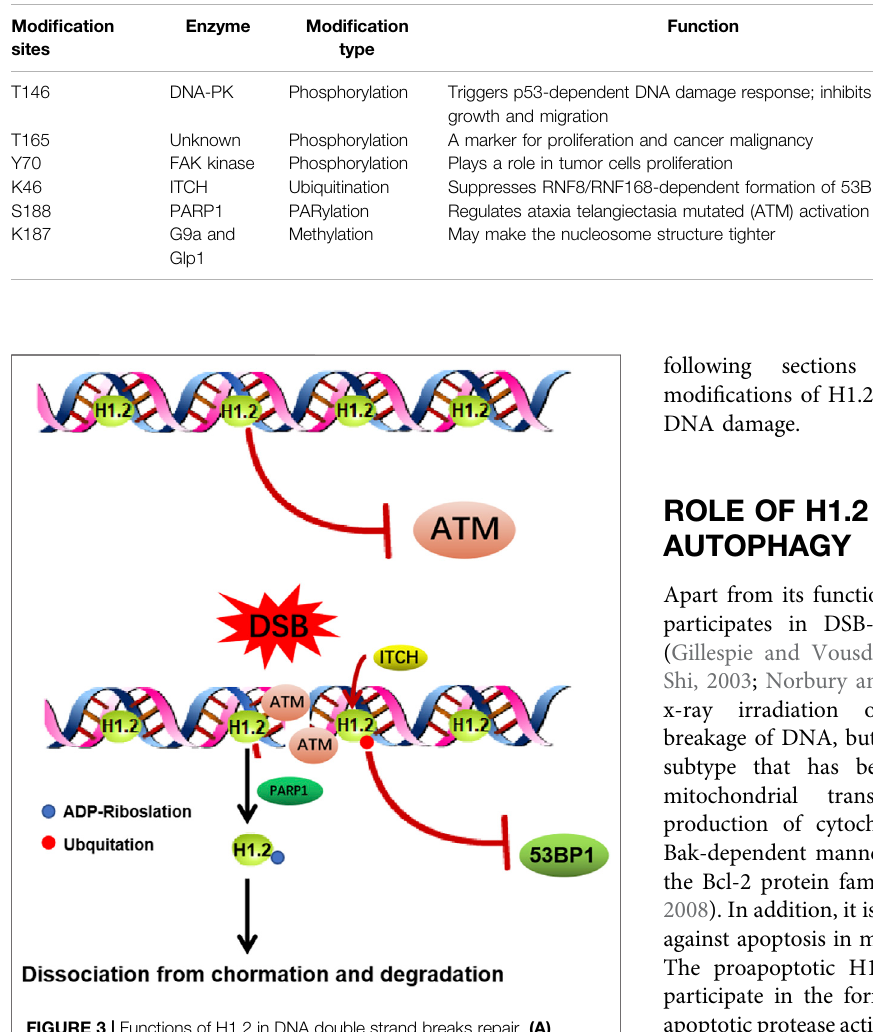
Frontiers in Cell and Developmental Biology |